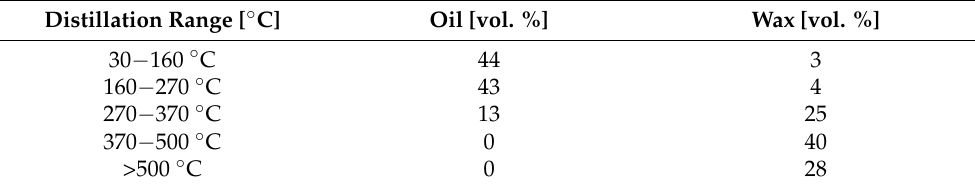
Table 2. The typical fractional composition of oil and wax produced by LTFT synthesis [41]. Distillation Range [ ◦ C] Oil [vol. %] Wax [vol.